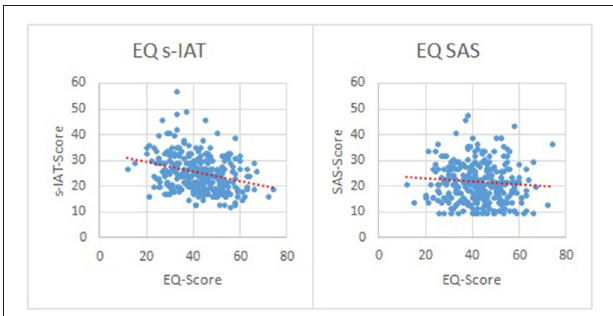
FIGURE 2 | Associations between EQ and IUD/SUD in the German sample (left side: r = − 0.29, p < 0.001; right side: r = − 0.08, p = 0.015).